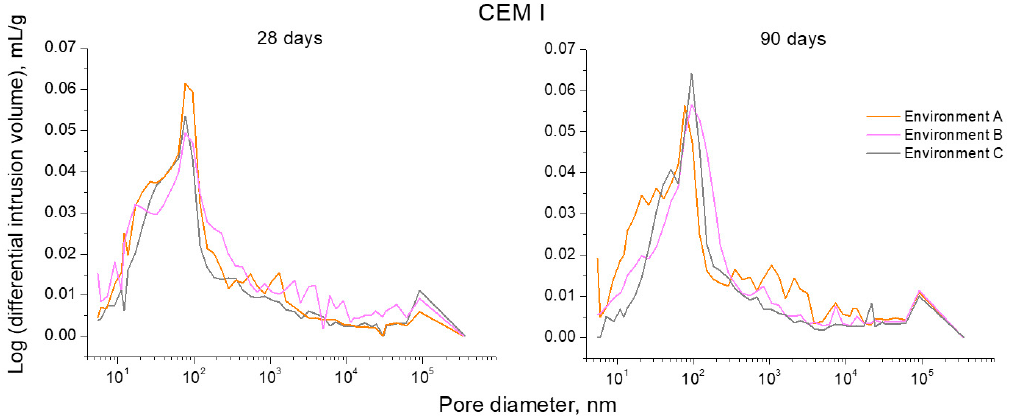
Figure 9. Curves logarithm of differential intrusion volume versus pore size obtained at 28 and 90 hardening days for CEM I mortars exposed to the three studied environments.